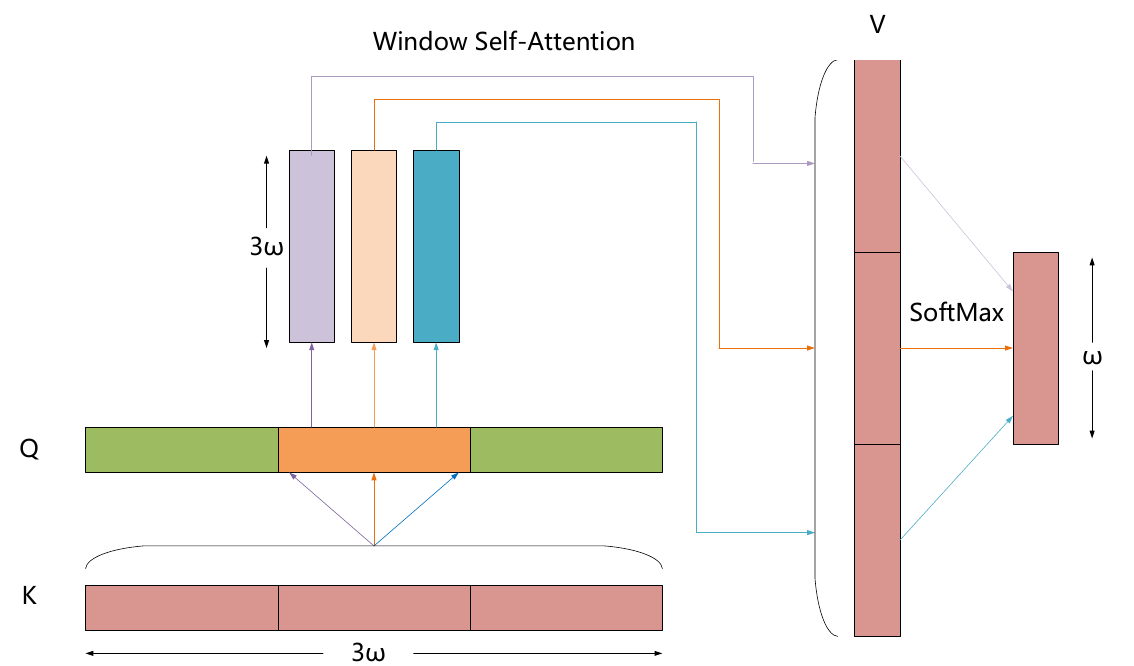
Figure 2. Visualization of window self-attention process. For a chunk region Ψ i ∈ [ t s , t e ] , we denote its region R Q = [ t s , t e ] , R K = [ t s − ω , t e + ω ] , R V = [ t s − ω , t e + ω ]